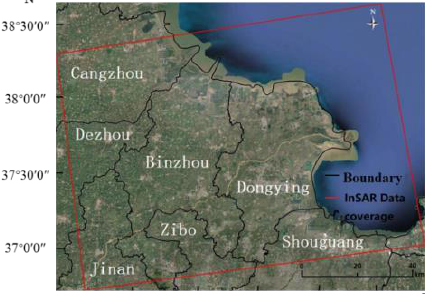
Figure 1. The coverage area of Sentinei-1A